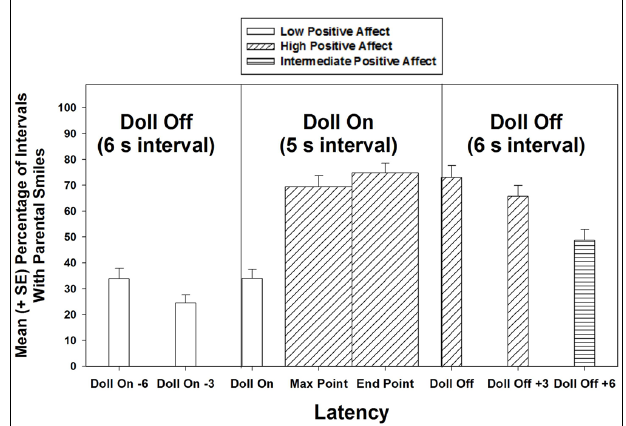
FIGURE 2 | Parents exhibited low positive affect until they pointed, at which time they exhibited high positive emotion. By 6 s after the doll